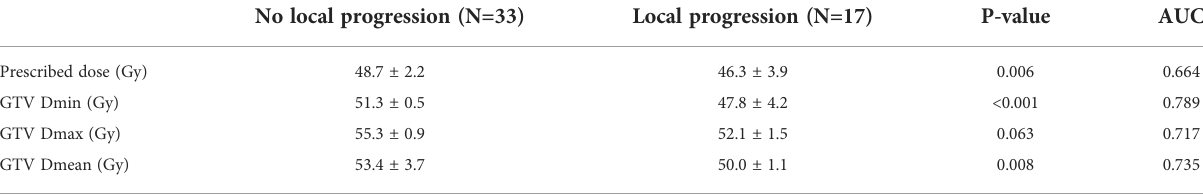
TABLE 3 Comparison of dosimetric parameters between patient groups with or without local progression within 3 years following SBRT.